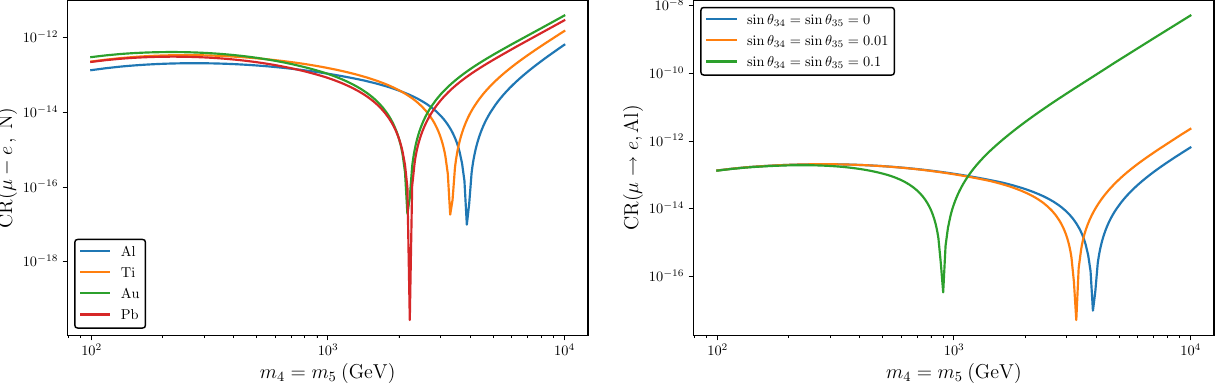
Fig. 7 Neutrinoless μ − e conversioninnucleiasafunctionofthedegenerateheavysterilemass, m 4 = m 5 (inGeV).Ontheleft,weset θ 1 j = 10 − 3 , θ = 0 . 01 and θ = 0 ( j = 4 , 5), and consider different muonic atoms: Aluminium (blue), Titanium (orange), Gold (green) and Lead (red). On 2 j 3 j the right, CR( μ − e , Al) for different values of the tau-sterile mixing angles: θ 3 j = 0 (blue), θ 3 j = 0 . 01 (orange) and θ 3 j = 0 . 1 (green), again with θ = 10 − 3 , θ = 0 . 01 (with j = 4 , 1 j 2 j